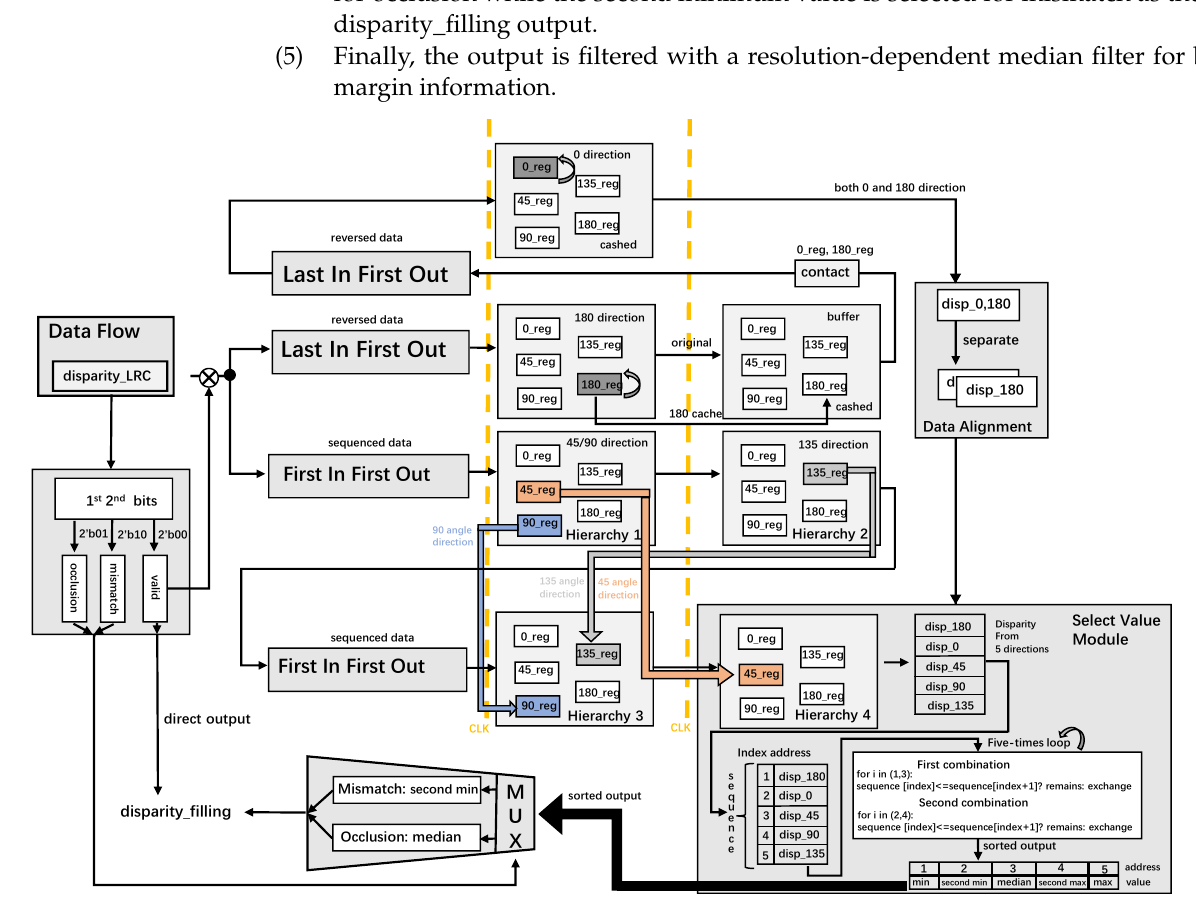
Figure 11. The alignment multi-direction occlusion filling module.